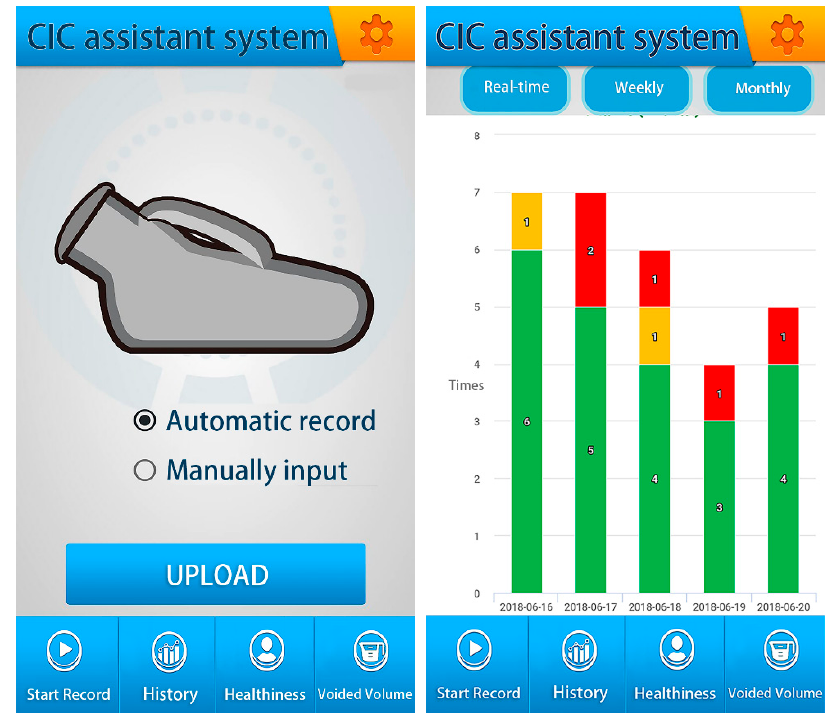
Figure 5. Urine volume record and statistics in the CIC assistant device ( left ) and the different color bars measuring the quantity of CIC volume level as in Table 1 ( right ).